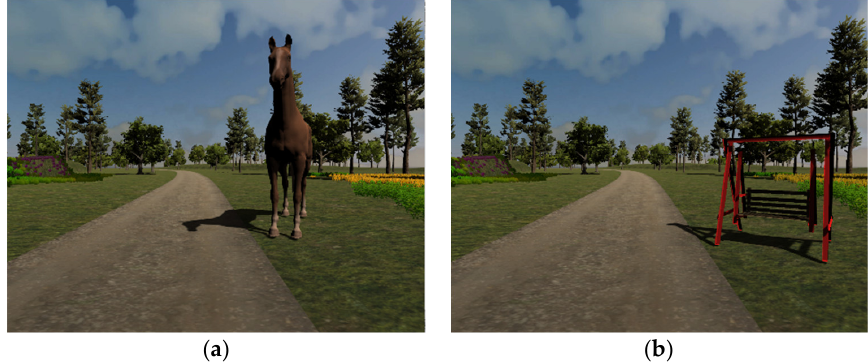
Figure 1. Examples of the two types of targets: A horse ( a ) and a colored swing ( b ).